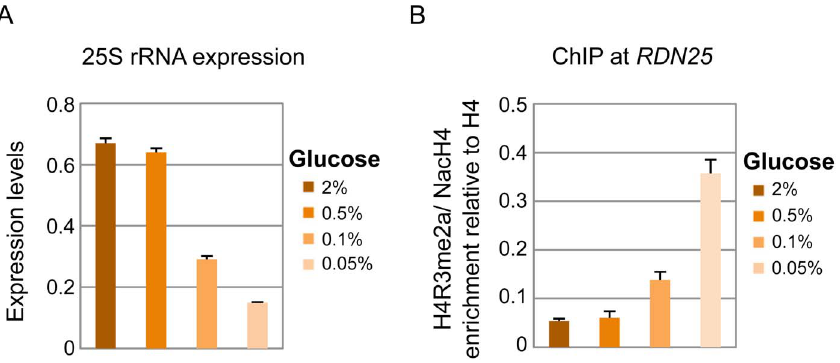
Figure 6. Calorie restriction increases RDN25 silencing and the H4R3me2a: NacH4 enrichment ratio. (A) The levels of 25S rRNA were analyzed by qRT-PCR using total RNA extracted from a wild-type strain (BY4741) grown in minimal media containing different glucose concentrations (2%, 0.5%, 0.1% and 0.05%). (B) ChIP experiments were performed in a wild-type BY4741 strain grown in the same conditions as in (A) , using antibodies against H4R3me2a and N-acH4. Their enrichment is normalized to histone H4 and represented as ratio of H4R3me2a to N-acH4. Error bars in (A) and (B) indicate s.e.m for duplicate experiments.